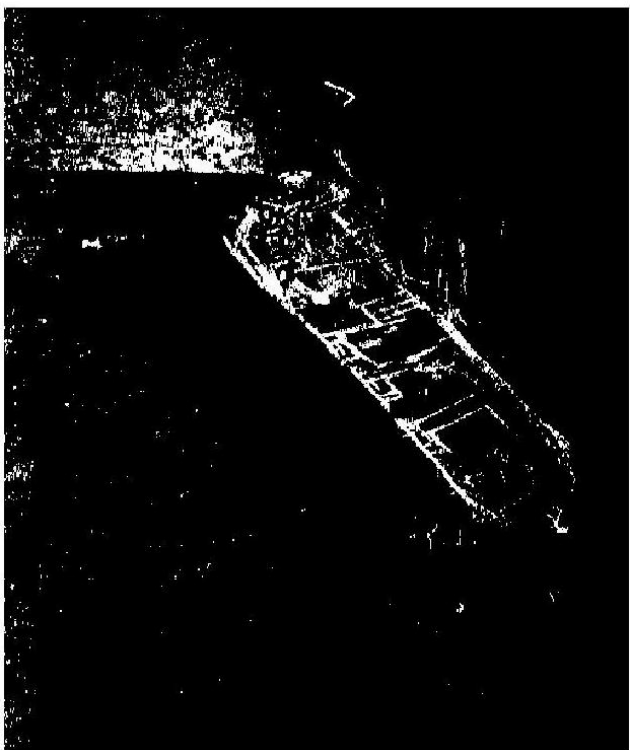
Figure 15. Result obtained by the proposed method 1—curve